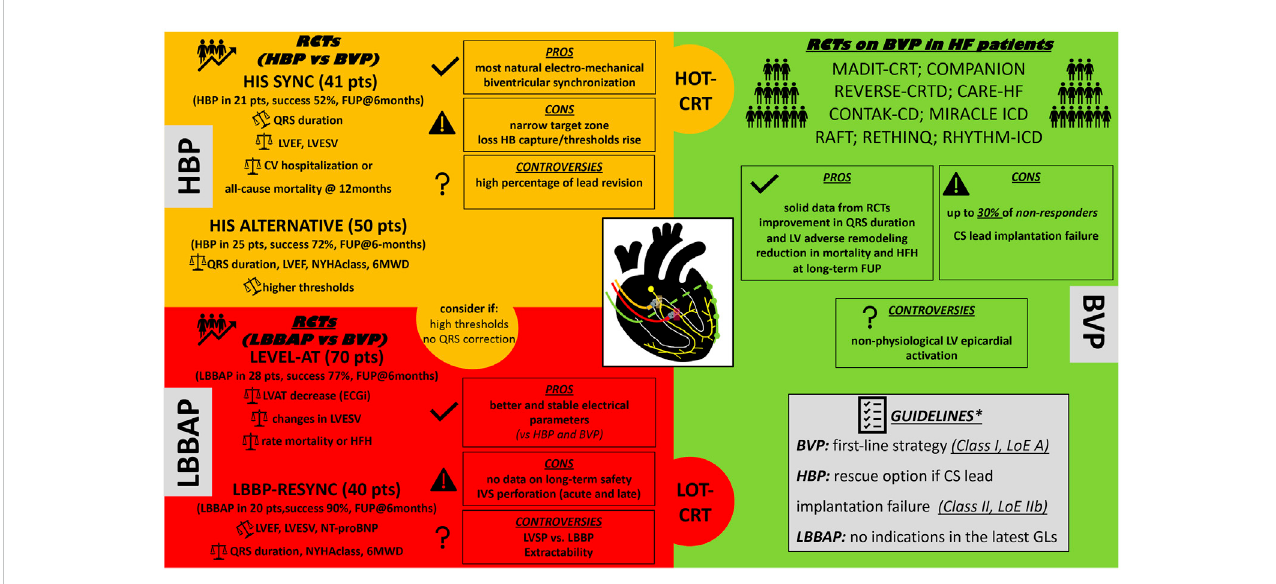
FIGURE 1 Proposed schematic “ puzzle ” resuming the available CRT techniques to perform cardiac resynchronization therapy. HBP, His bundle pacing; RCTs, randomized control trials; BVP, biventricular pacing; LVEF, left ventricle ejection fraction; LVESV, left ventricle end systolic volume; HB, His Bundle; NYHA, New YorkHeart Association functional class;6MWD,6-minutes walking distance; CV, cardiovascular;FUP, follow-up;LBBAP, leftbundle branch areapacing; LVAT, left ventricle activation time; CRT, cardiac resynchronization therapy; HOT-CRT, His optimized CRT; LOT-CRT, left bundle branch pacing optimized CRT; HFH, heart failure hospitalizations; LVSP, left ventricle septal pacing; IVS, interventricular septum; RCTs, randomized control trials; CS, coronary sinus; LV, left ventricle; LoE, level of evidence; GLs, guidelines. *2021 ESC Guidelines on cardiac pacing and cardiac resynchronization therapy. Eur Heart J. 2021; 42 (35):